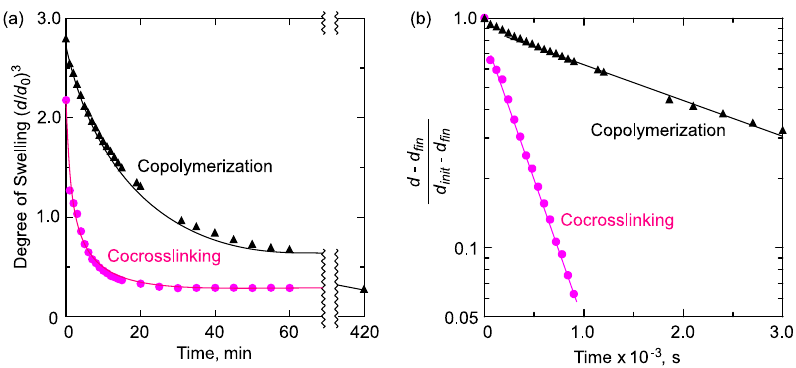
Figure 7. ( a ) Shrinking behavior of the copolymerization and the co-crosslinking gels of NIPAAm and DMAAm (7:3) against a temperature jump from 5 to 50 °C and ( b ) kinetic analysis of shrinking behavior upon temperature jump. When an isotropic shrinking is observed, the relaxation time ( τ ) can be determined from the slope of the line ( − 1/ τ )